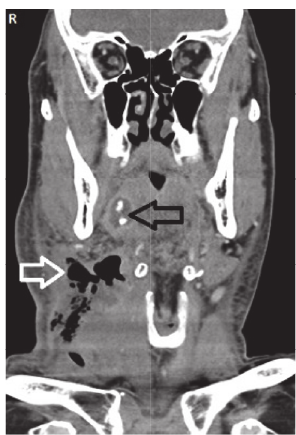
Figure 1: Coronal neck CT image showing cervical subcutaneous gas (white arrow) and right inflamed submandibular gland region with ductal stones (black arrow).